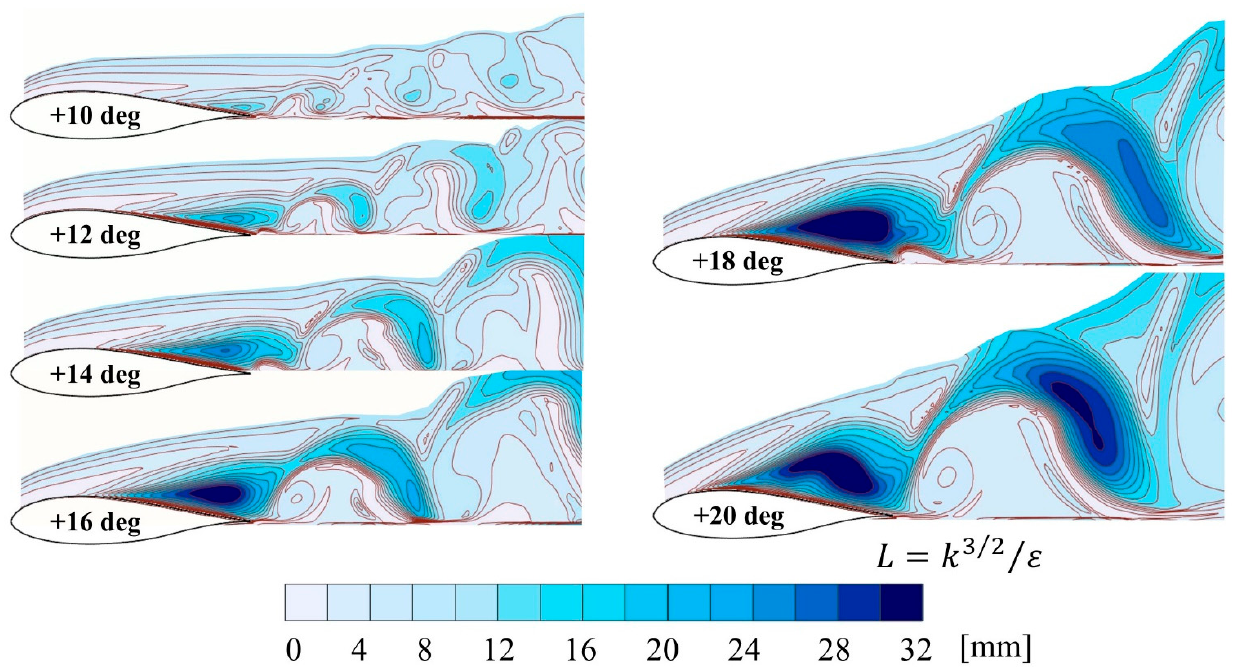
Figure 10. Integral length scales in the airfoil wake for positive AoA = 10°, 12°, 14°, 16°, 18° and 20°.